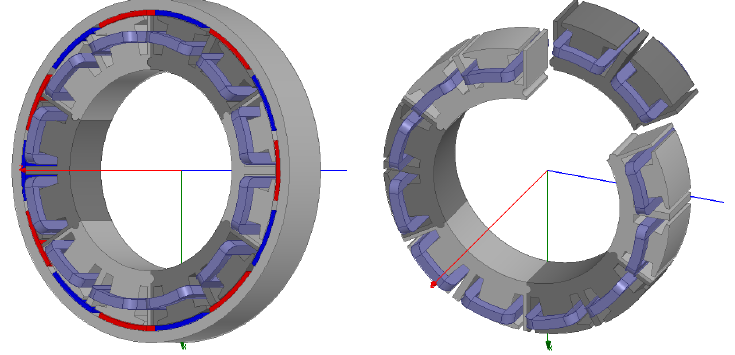
Figure 16. The optimal design scheme: ( a ) assembly; and ( b ) modular